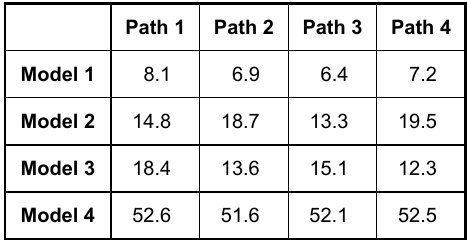
Table 1. Average FPS values for four paths and